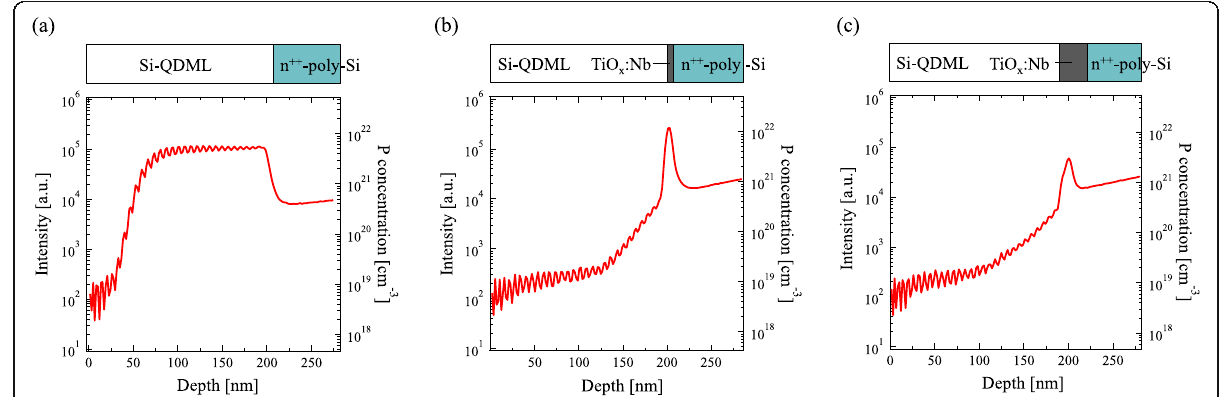
Fig 4 Depth profile of phosphorus atoms in a Si-QDML/n ++ -poly-Si and Si-QDML/TiO x :Nb/n ++ -poly-Si structure using b 2-nm-thick TiO x :Nb and c 10-nm-thick TiO x